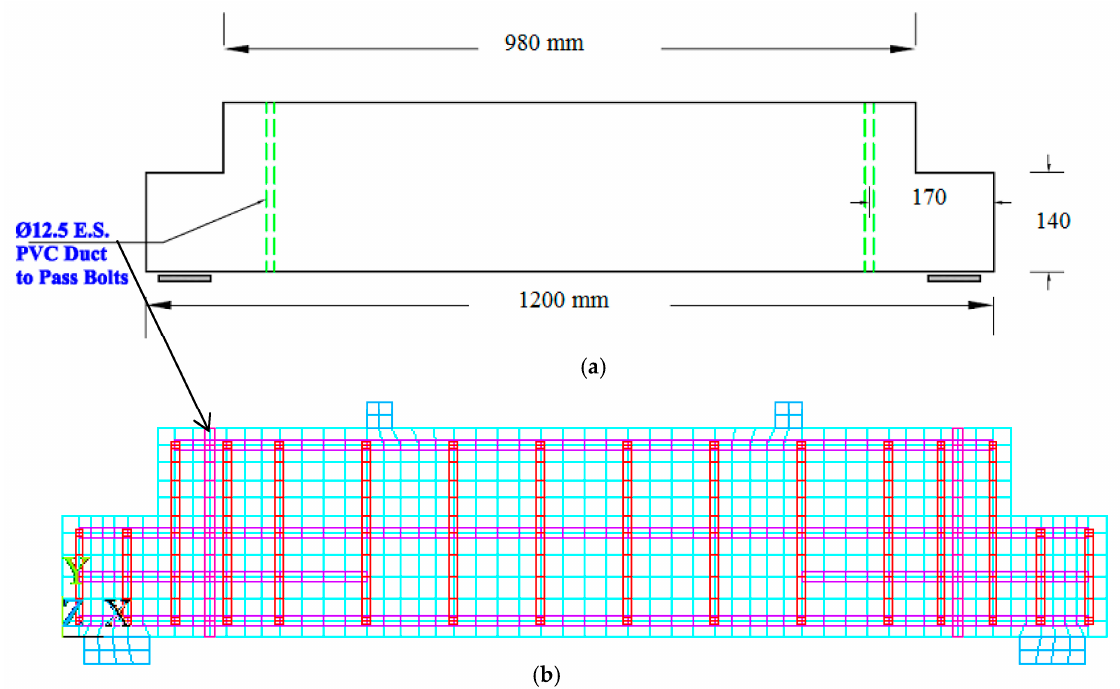
Figure 4. Experimental details and numerical simulations of model DET3. ( a ) Geometry layout in the previous experimental investigation [39]. ( b ) Numerical modelling.